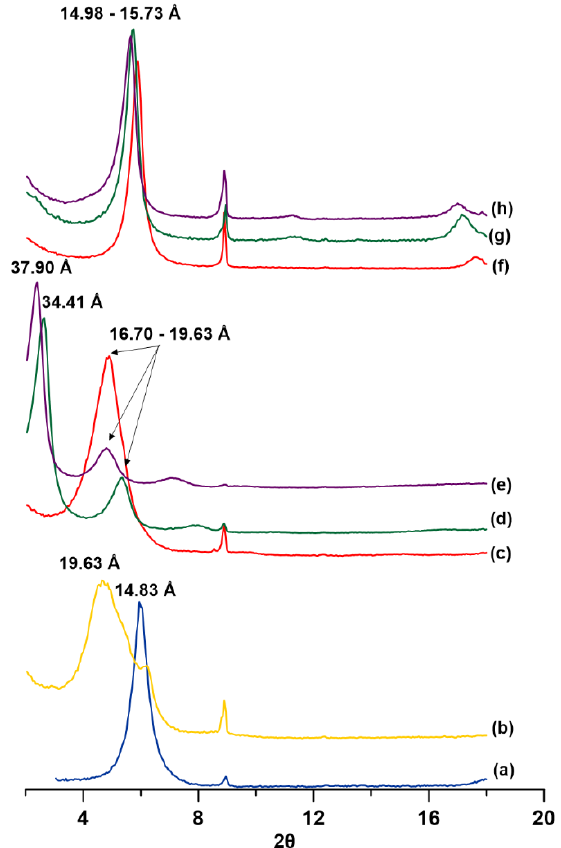
Figure 2. X-ray di ff raction patterns of: ( a ) natural bentonite (BENT); ( b ) bentonite modified with HDTMA only (HD-B); ( c ) bentonite modified with HDTMA and TX100 (2 mmol of TX100 / 100 g) (HD-TX-2); ( d ) bentonite modified with HDTMA and TX100 (48 mmol of TX100 / 100 g) (HD-TX-48); ( e ) bentonite modified with HDTMA and TX100 (120 mmol of TX100 / 100 g) (HD-TX-120); ( f ) bentonite modified with TX100 alone (2 mmol of TX100 / 100 g) (TX-2); ( g ) bentonite modified with TX100 alone (48 mmol of TX100 / 100 g) (TX-48); ( h ) bentonite modified with TX100 alone (120 mmol of TX100 / 100 g)